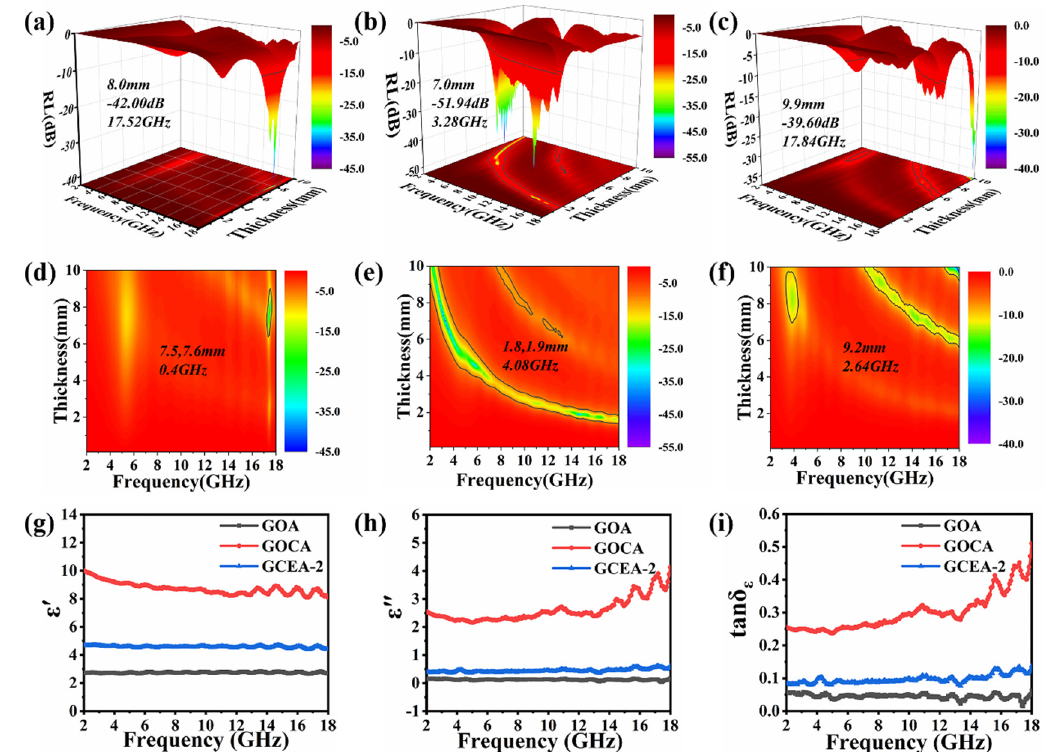
Figure 8. The reflection losses (RL) of the various samples in 2–18 GHz frequency range, ( a – c ), 2D plots ( d – f ) of GOA, GOCA, GCEA-2 with effective absorption bandwidth. frequency dependence of ( g ) ε ′ , ( h ) ε ″ , ( i ) tan δ ε (Color figure can be viewed online).